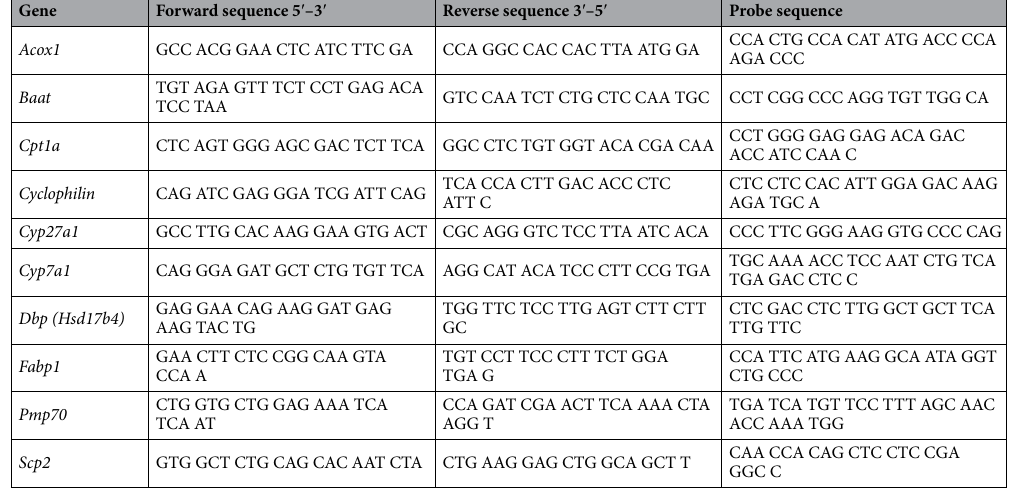
Table 1. Taqman primer sequences.